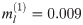
Boundaries between strains with different chiralities create front undulations.(A) A magnified view of the colony front shows bulges and dips near in-flow and out-flow boundaries. The analytical solutions for the shape of bulges and dips are shown in panels (B) and (C) respectively. Note that both the theory and the simulations predict an approximately triangular bulge shape. Here, m0 = ms = mb = md = 0, g = 0.1, N = 200 for both strains, and ml(1)=0.009, mr(1)=0.001, ml(2)=0.001, mr(2)=0.009 on a lattice of 2400x2100 sites in panel(A). The chirality of the strains is shown with thick white arrows. All distances were measured in 100 units where Δx = Δy = 1 unit.